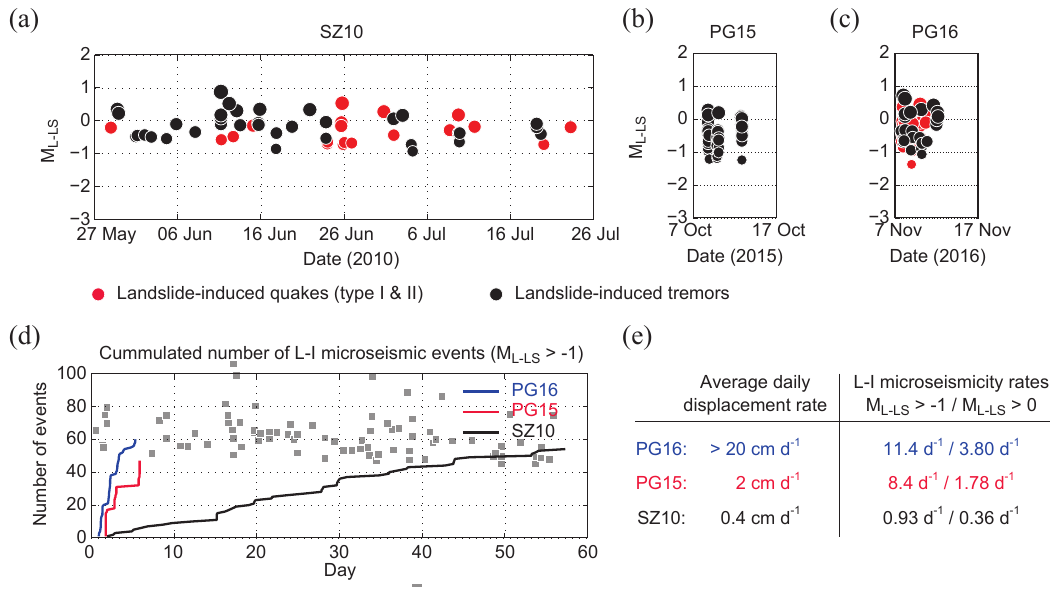
Figure 15. (a–c) Temporal distribution of M L − LS for near-source area ( < 50m) landslide-induced microseismic events at SZ10 (a) , PG15 (b) and PG16 (c) . Red circles show quake events type I and II and black circles indicate landslide-induced tremors (ETS-like, rockfall, harmonic and dispersive with S > 200%). The timescale is constant in all plots. (d) Cumulative number of landslide-induced microseismic events with S > 200% curves for M L − LS > − 1 events. (c) Daily landslide-induced microseismicity rates for M L − LS > − 1 and M L − LS > − 0 show an increase with higher average daily displacement